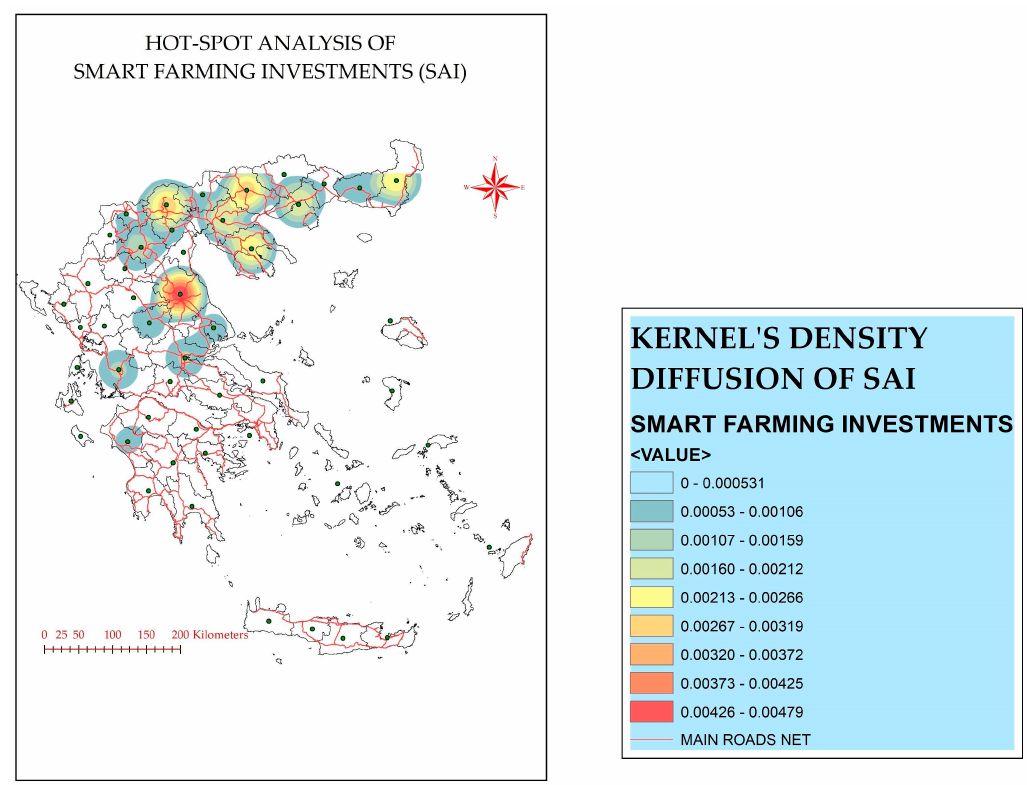
Figure 6. Probability of diffusion of SAI using kernel density (designed own elaboration in ESRI ArcGIS PRO and depicted own elaboration in ESRI ArcGIS